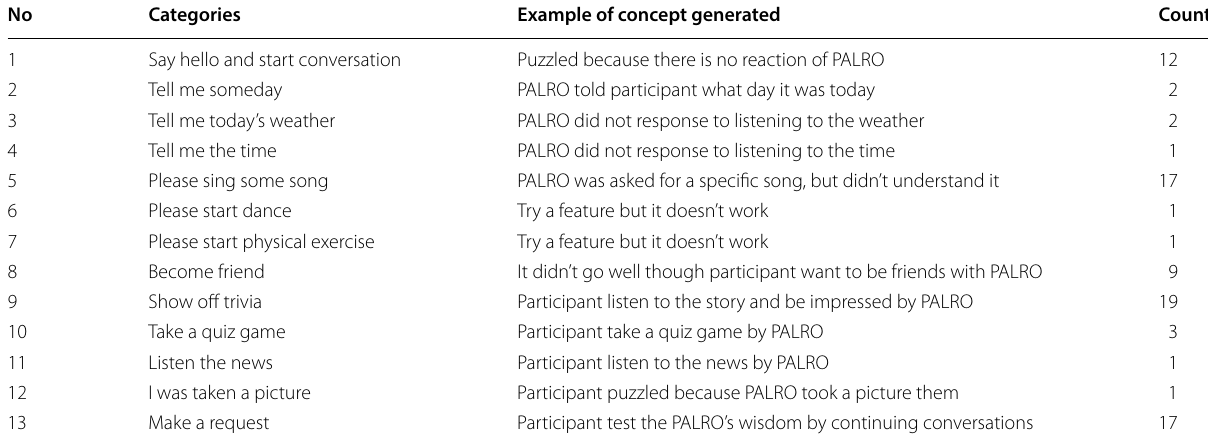
Table 6 Extracted categories and